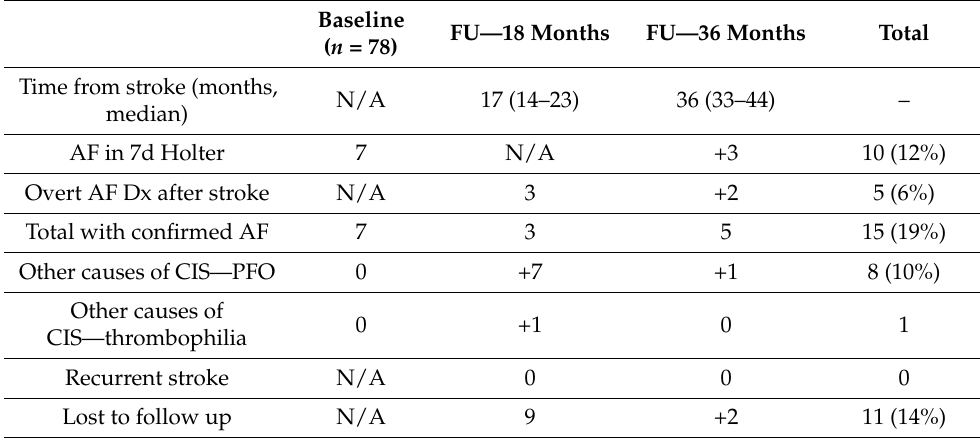
Table 2. The 36 months of follow-up.